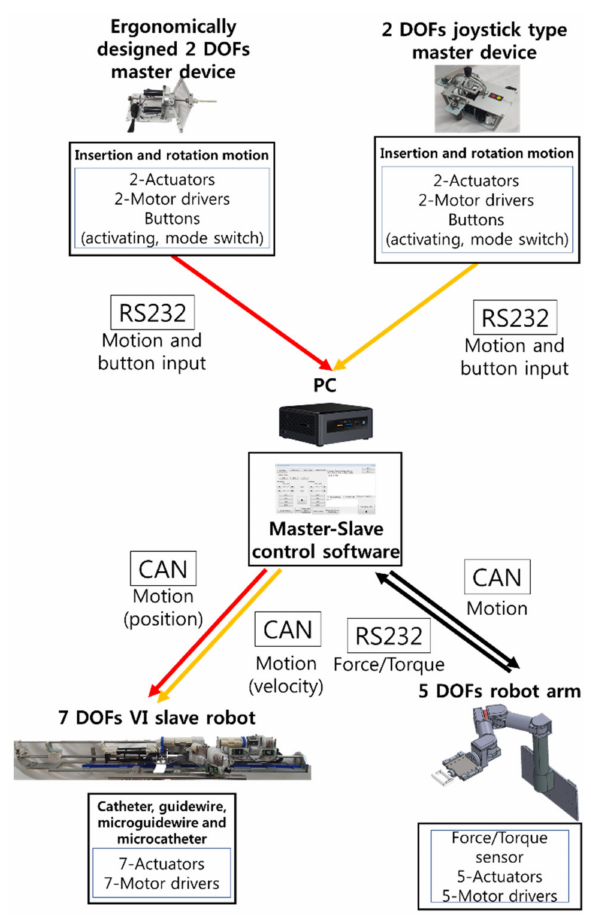
Figure 8. System control block diagram of the proposed robotic VI